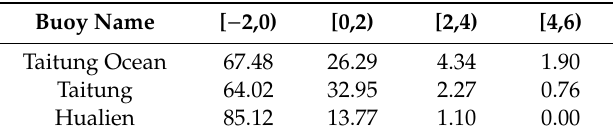
Table 4. Percentage of model-data di ff erence for di ff erent classes and buoys using winds from